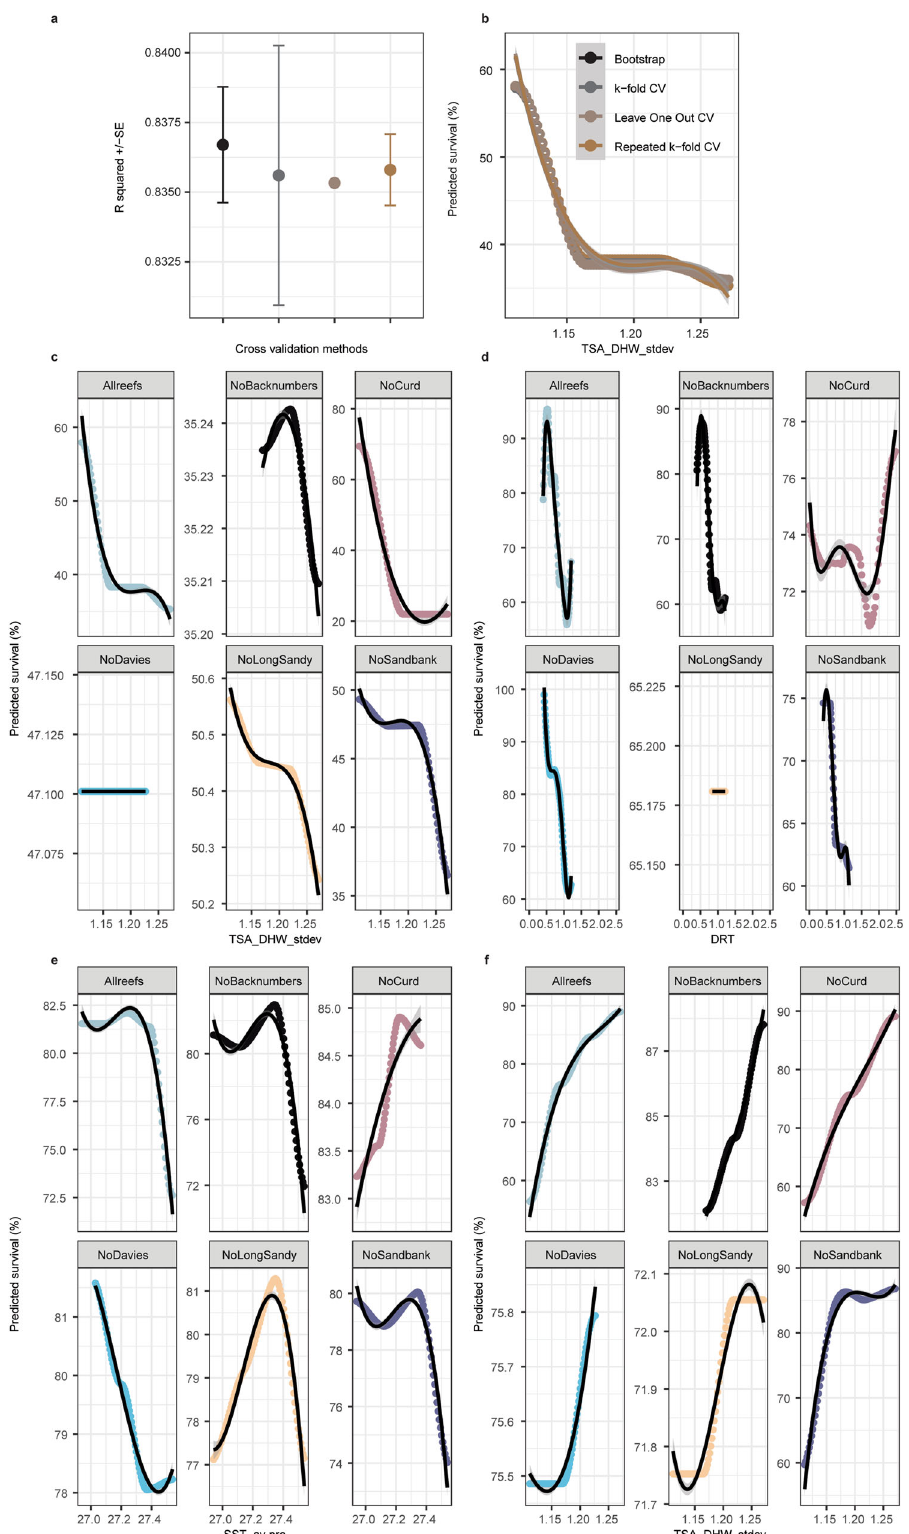
Fig. 6 Assessment of the impact of various Cross Validation (CV) methods on model construction. Three CV methods were compared to the chosen Repeated k-fold CV, including Bootstrap, k-fold, and Leave One Out (mean R 2 ± Standard Error bars [SE]). Derived statistics are de fi ned as n = independent R 2 estimates for each of the 3000 model runs per CV method ( a ) using a subset of the data (purebred larval crosses) to inspect the resulting impact on the intrinsic resistance models ( b ). Further validation of predicted percent (%) survival included dropping whole reefs from each of the datasets ( c - purebred larva, d - hybrid larva, e - purebred D1 juveniles, f - hybrid D1 juveniles). Please note the differences in y-axis values between groups of panels. Y -axis values within each analysis group was consistent but were allowed to vary across groups to facilitate comparisons between predicted versus actual survival estimates. Colours correspond to different CV methods or where the maternal corals were sourced ( c – f ). NATURE COMMUNICATIONS| (2022) 13:1543